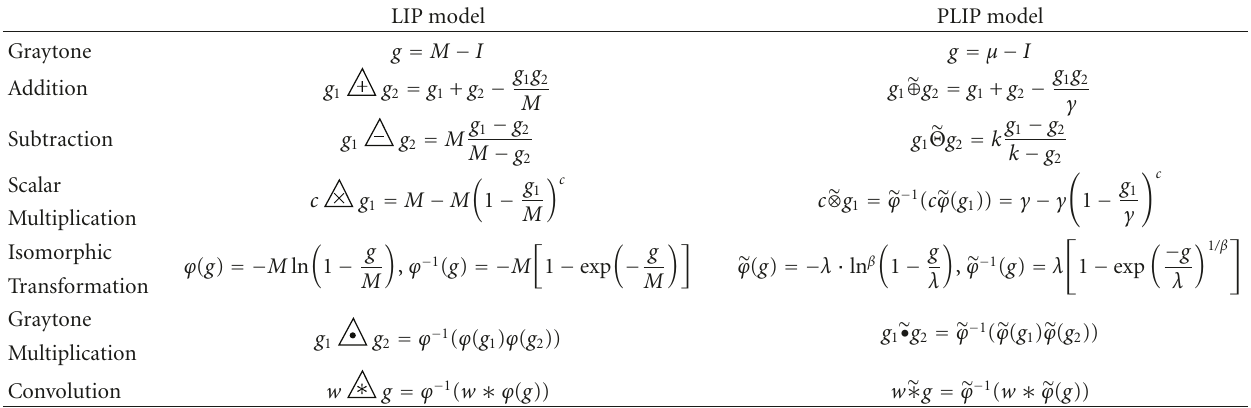
Table 1: Summary of the LIP and PLIP model mathematical